Question: Identify the chart type used in this figure.
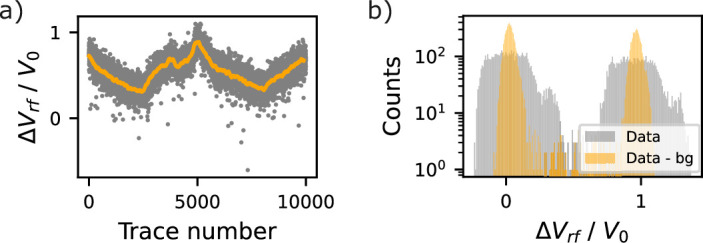
Answer: histogram